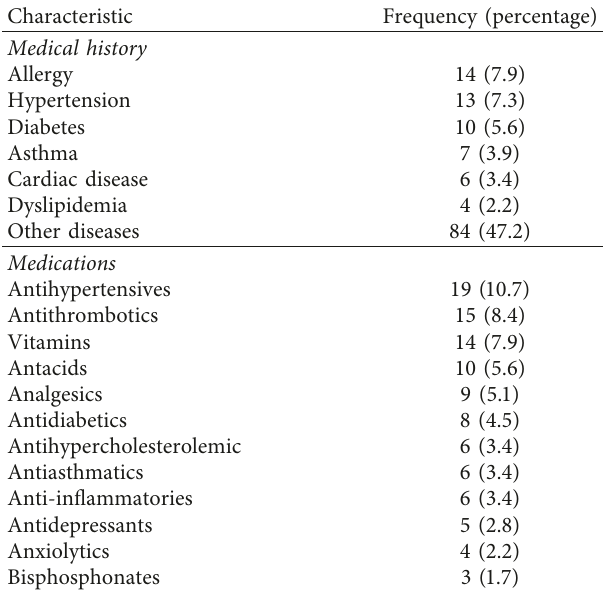
Table 3: Patients’ medical and medications history ( n � 178).